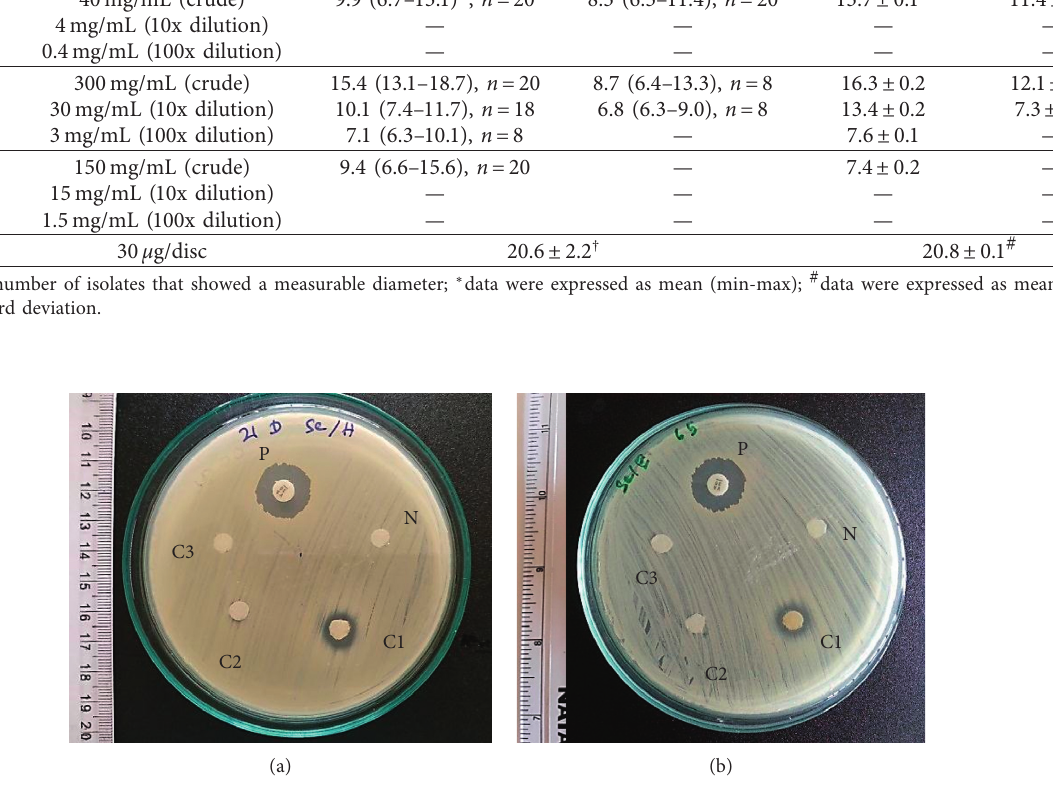
Figure 3: Inhibitory zones of crude extracts of V. zizanioides : (a) hexane extract; (b) ethanol extract. P: positive control; N: negative control; C1: crude extract; C2: 10-fold dilution of crude extract; C3: 100-fold dilution of crude